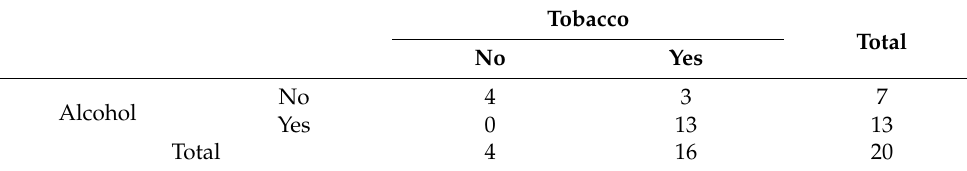
Table 3. Males risk factors crosstab.